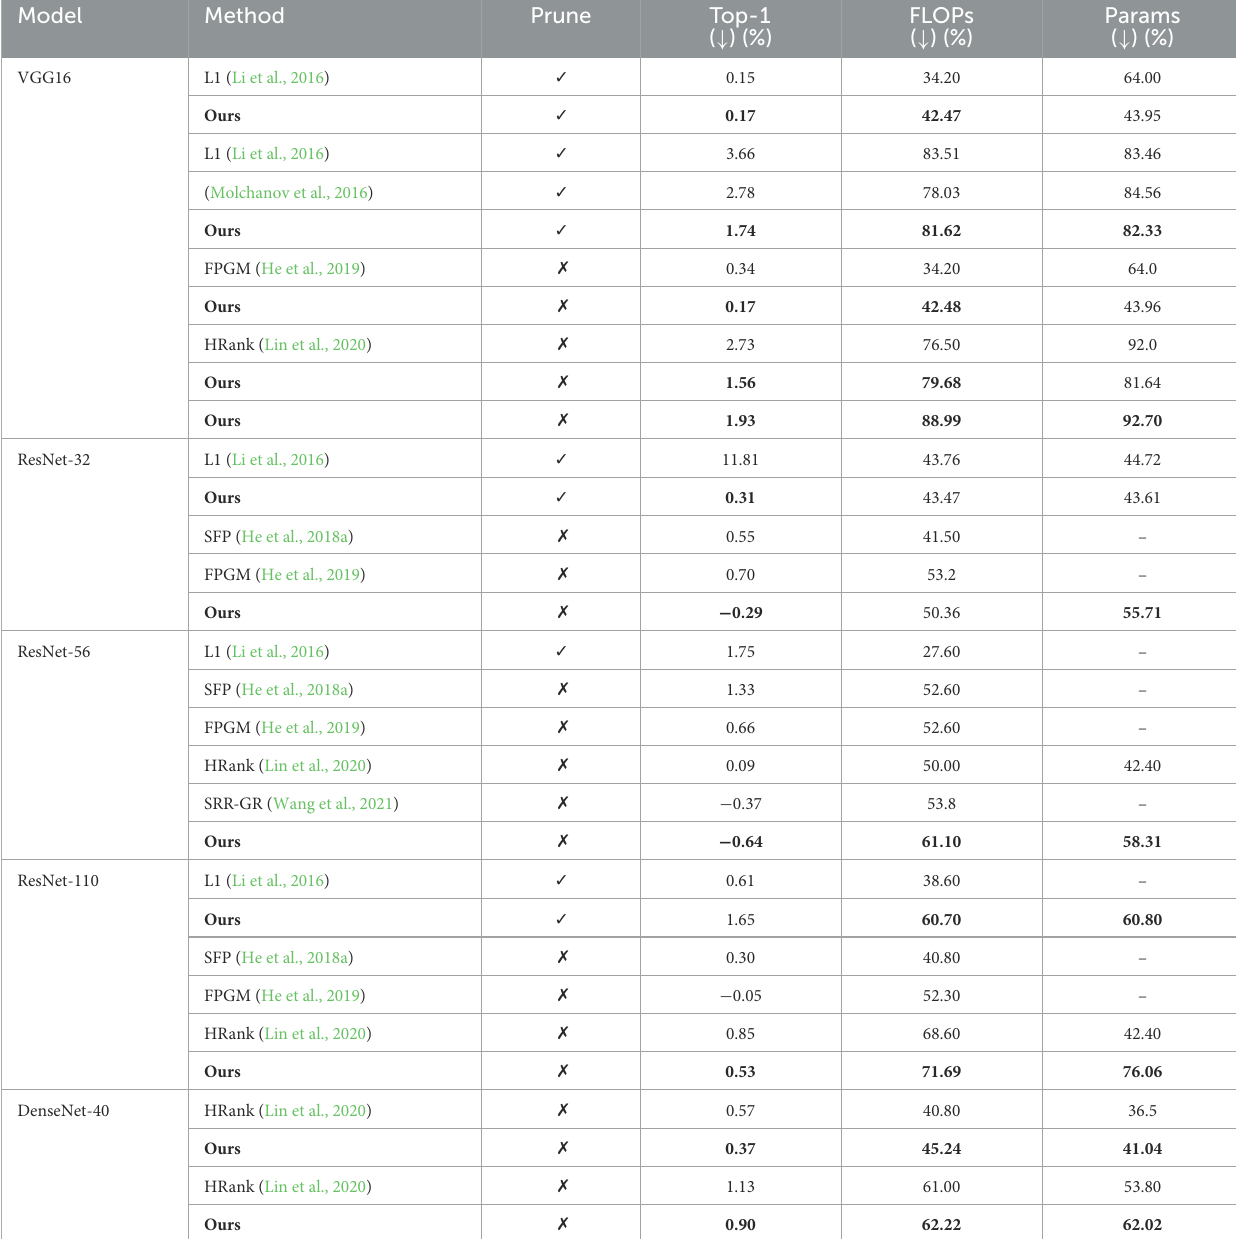
TABLE 2 Comparison of the results of different network structures on the CIFAR10 dataset.